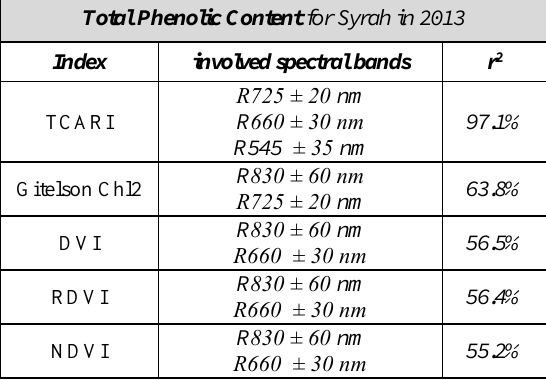
Table 3. The highest correlation rates regarding the estimation of Total Phenolic Content for Syrah vineyards in 2013